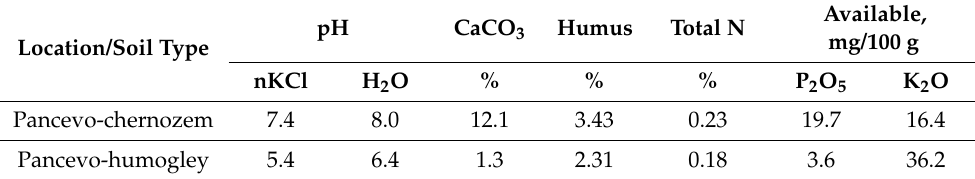
Table 1. The agrochemical properties of soil 1 .